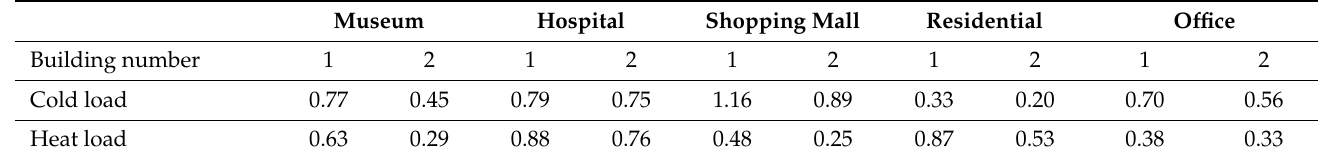
Figure 4. Typical daily changes in the four seasons of office buildings (electricity load, ( a ) Office 1; ( b ) Office 2). Table 2. Equivalent hours of cooling and heating load